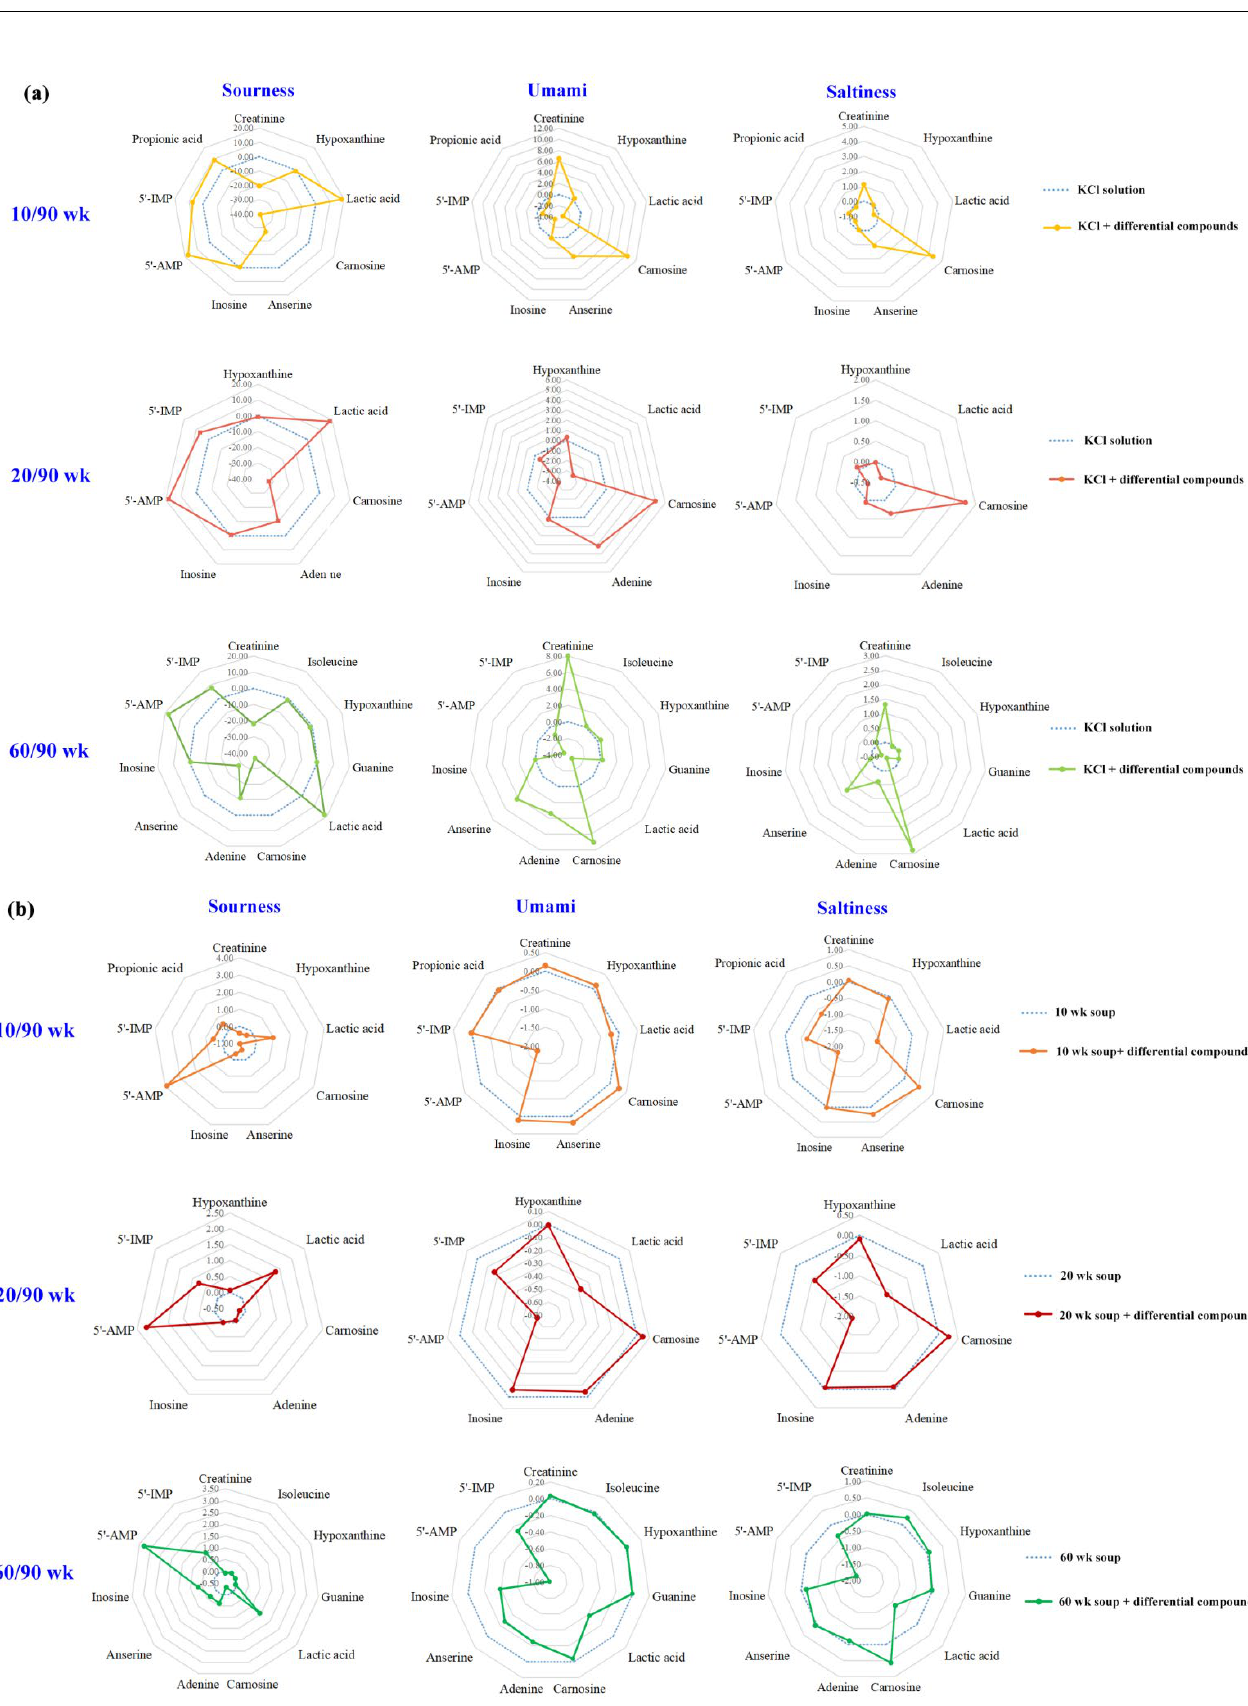
Figure 5. Taste evaluation of differential compounds in KCl solution ( a ) and chicken soup ( b ) by the electronic tongue.